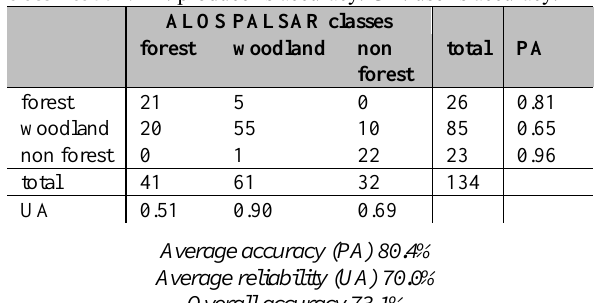
Table 1. Confusion table for a forest/woodland/non-forest classification. PA: producer’s accuracy. UA: user’s accuracy.